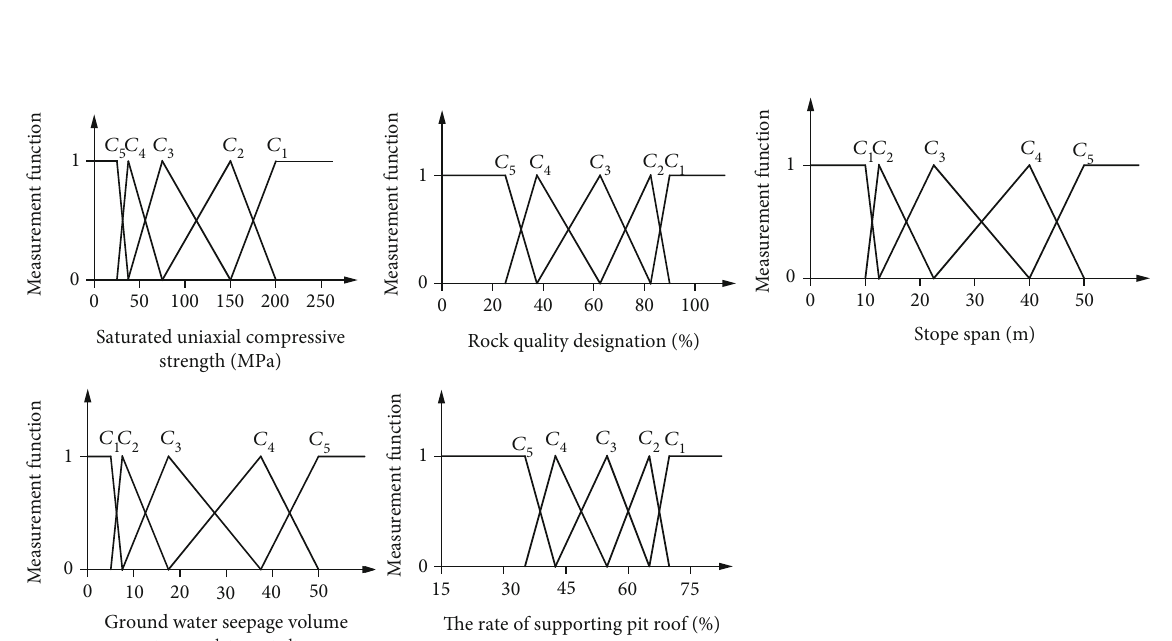
Figure 1: Unascertained measurement function of each quantitative